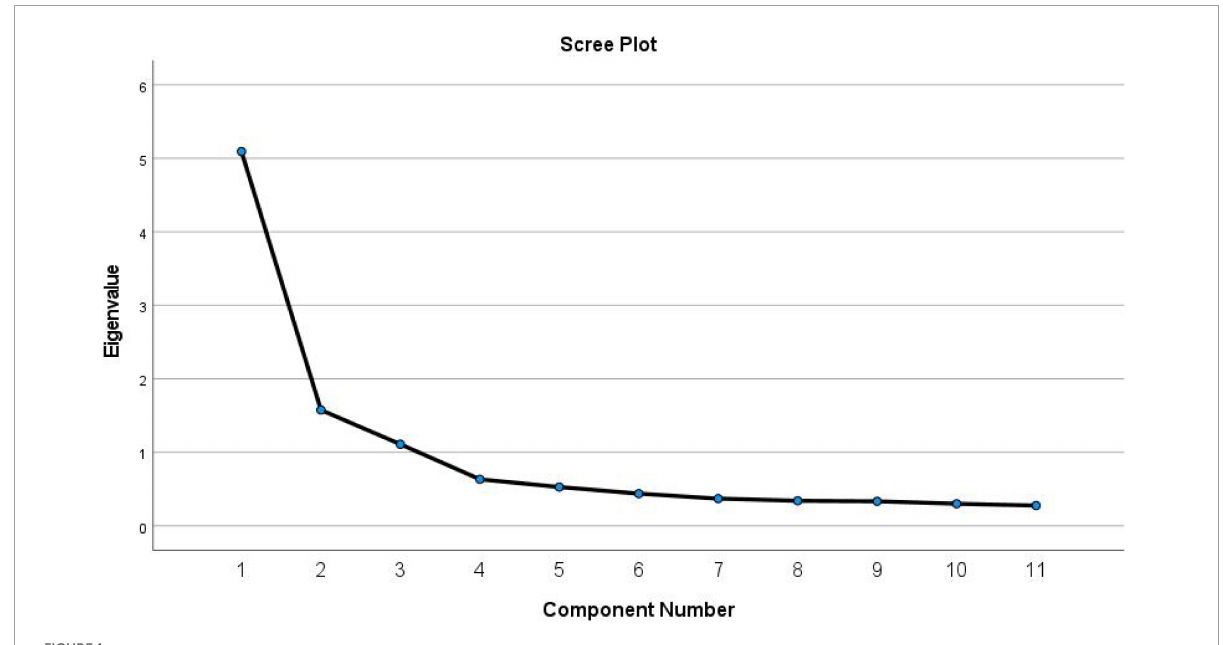
FIGURE1 Screen plot of exploratory factor analysis for the Chinese version of the active-empathic listening scale (AELS).